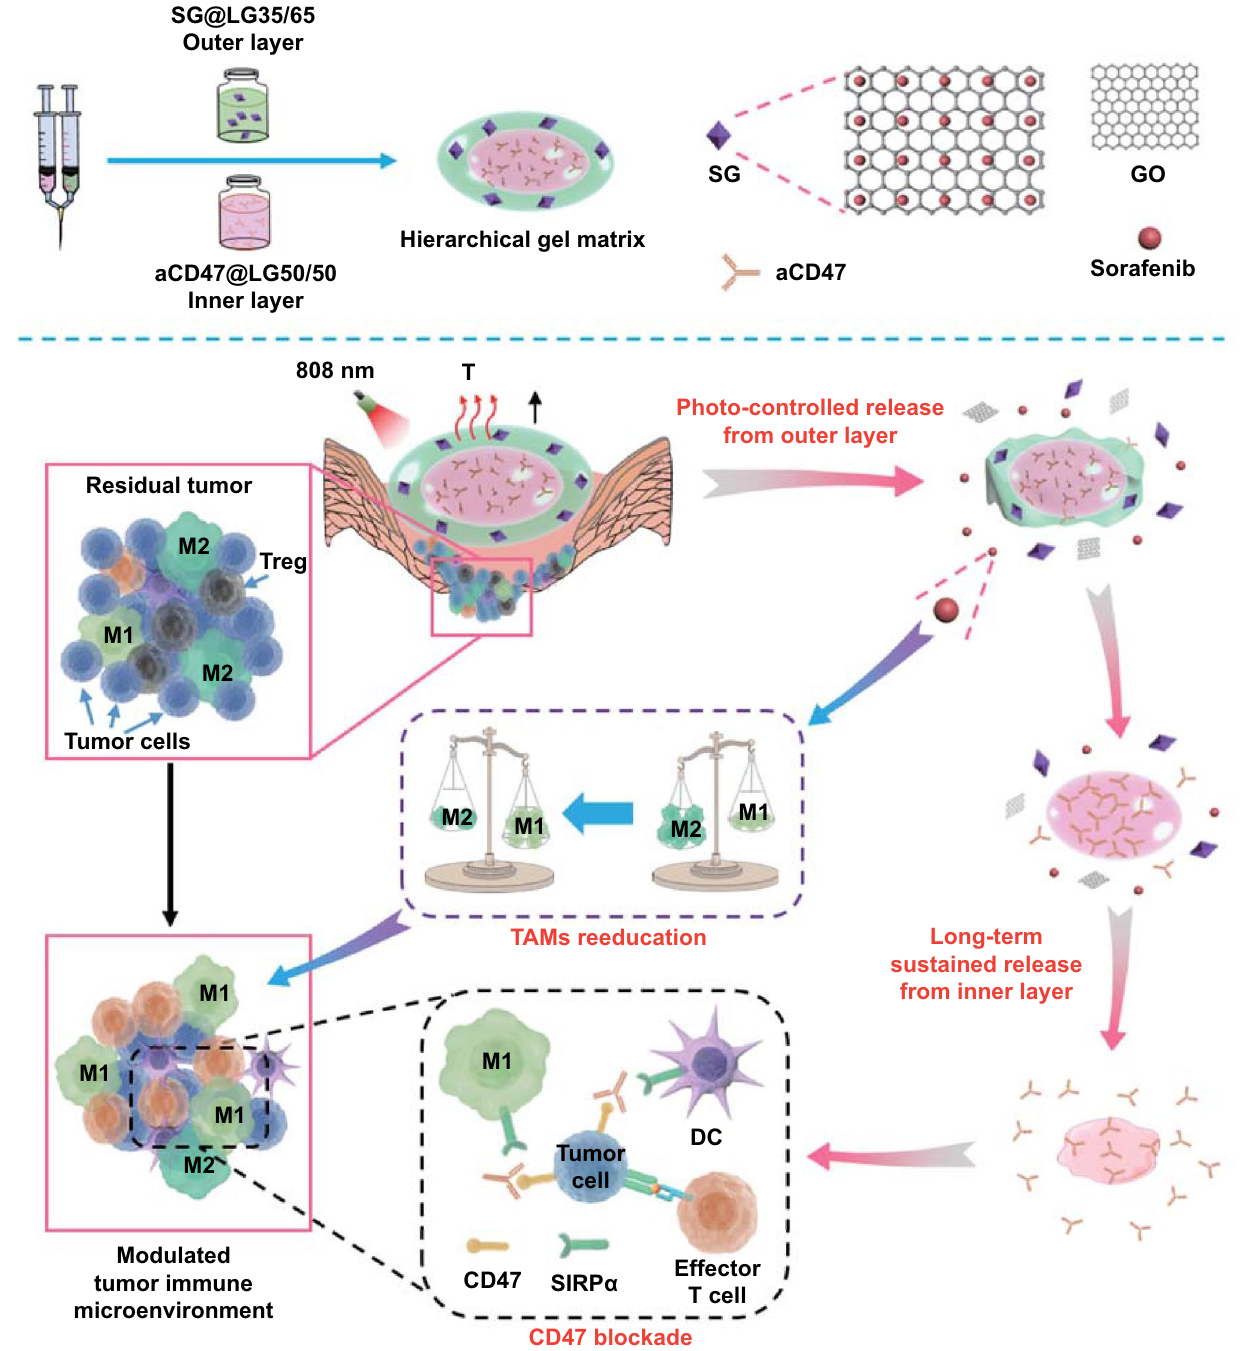
Fig. 1 Schematic illustration of time-programmed sequential delivery of combined cancer immunotherapy via a hierarchically structured gel matrix (DLG scaffold) for postsurgical tumor immune microenvironment